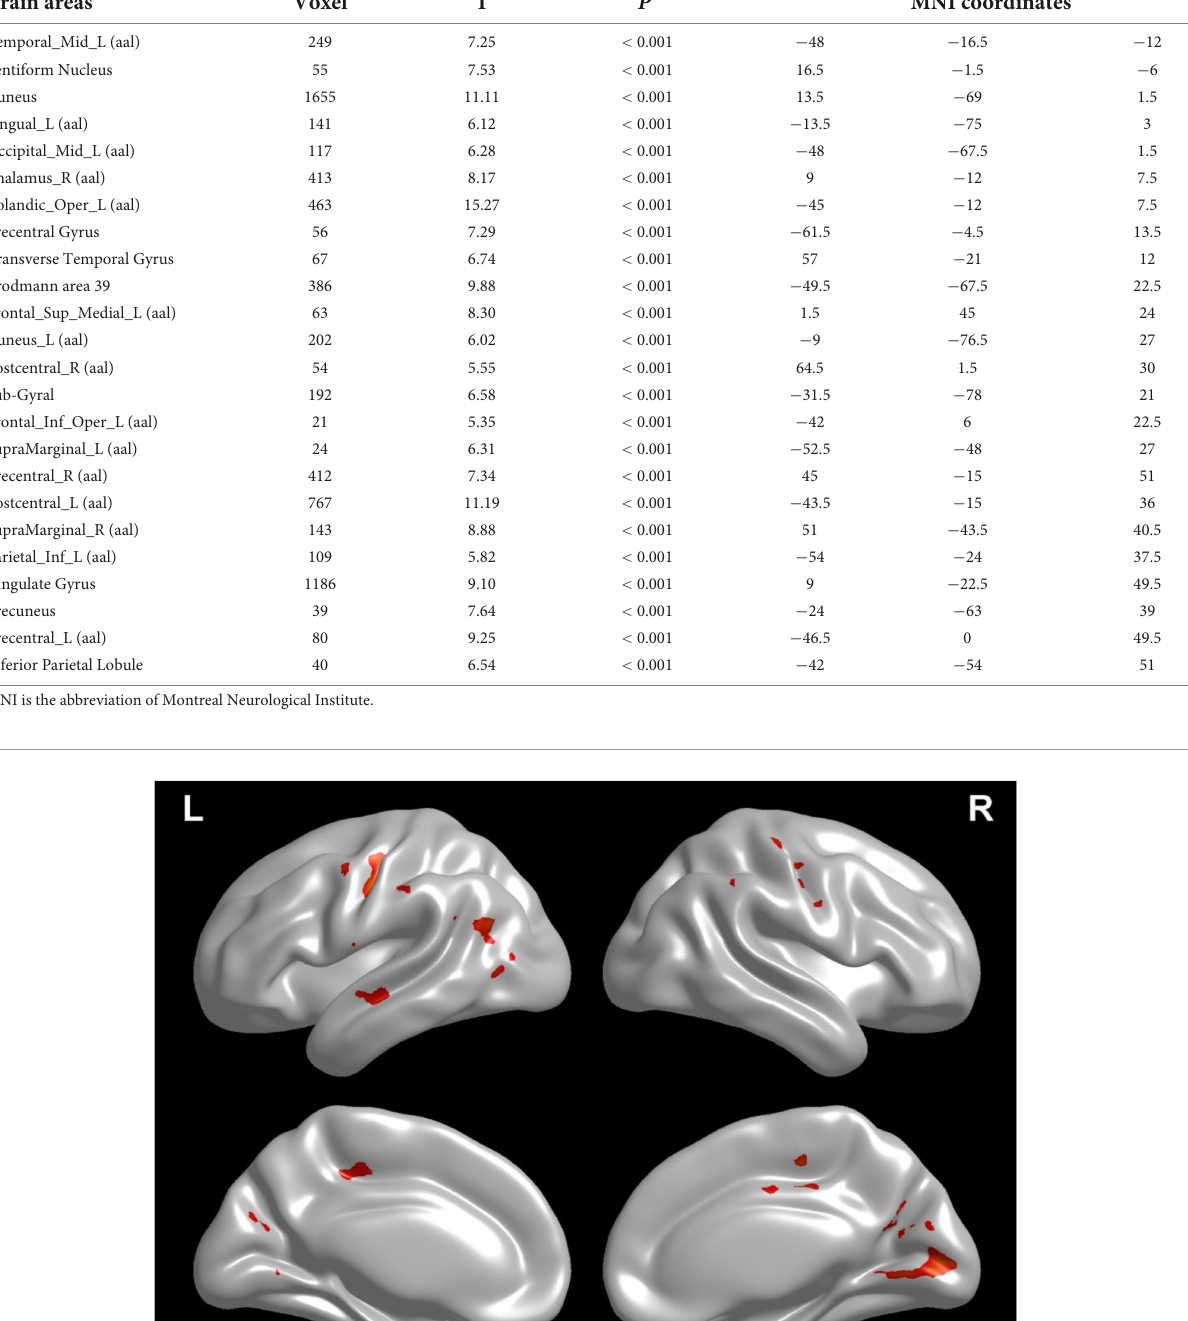
TABLE 2 Differences in brain gray matter among participants in rehydration state in test 3 and participants in dehydration state in test 2. Brain areas